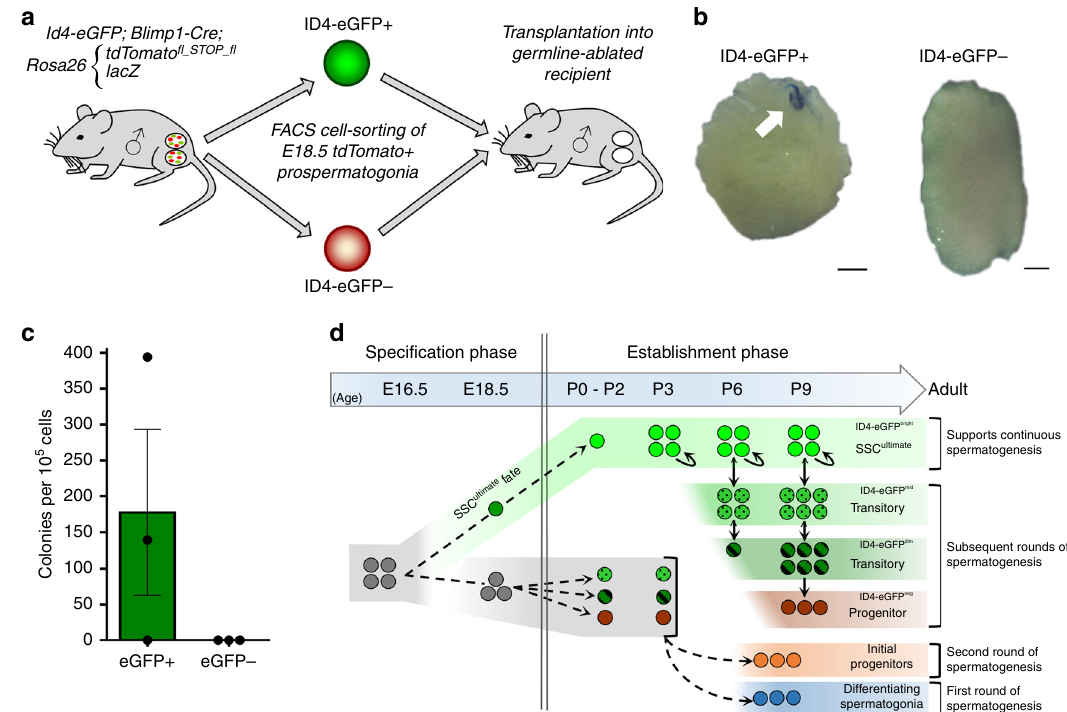
Fig. 7 Functional assessment of SSC fate speci fi cation in subsets of fetal prospermatogonia. a – c Schematic of transplantation experimental approach a , representative images of recipient testes after X-gal staining to discern donor-derived spermatogenic colonies ( b ; scale bars, 1 mm), and stem cell quanti fi cation c . Data are presented as means with error bars representing SEM for n = 3 biologically independent donor prospermatogonial suspensions divided into either ID4-eGFP + (2366 total cells) and ID4-eGFP − (20,002 total cells) and transplanted into 14 or 15 recipient testes, respectively. Source data are provided as a Source Data fi le. d Proposed model explaining the kinetic mechanisms that guide establishment of spermatogonial subsets, including the foundational SSC pool, during neonatal life from prospermatogonial precursors that were preprogrammed in late fetal